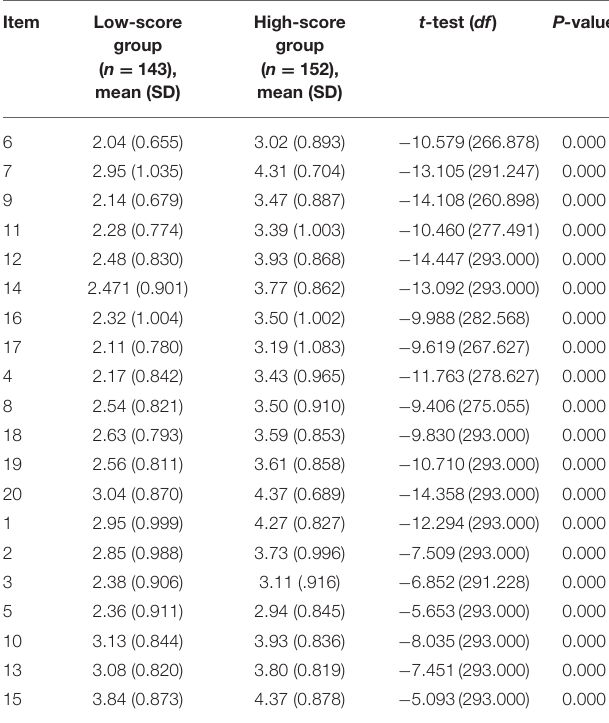
TABLE 4 | Discriminant validity analysis of the Chinese version of the scale.